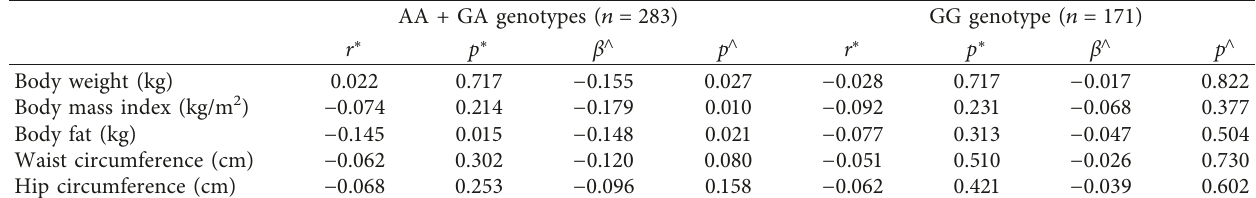
∗ Spearman correlation analysis; ∧ linear regression analysis with correction for sex, age, total energy intake, table sugar intake, and total caffeine